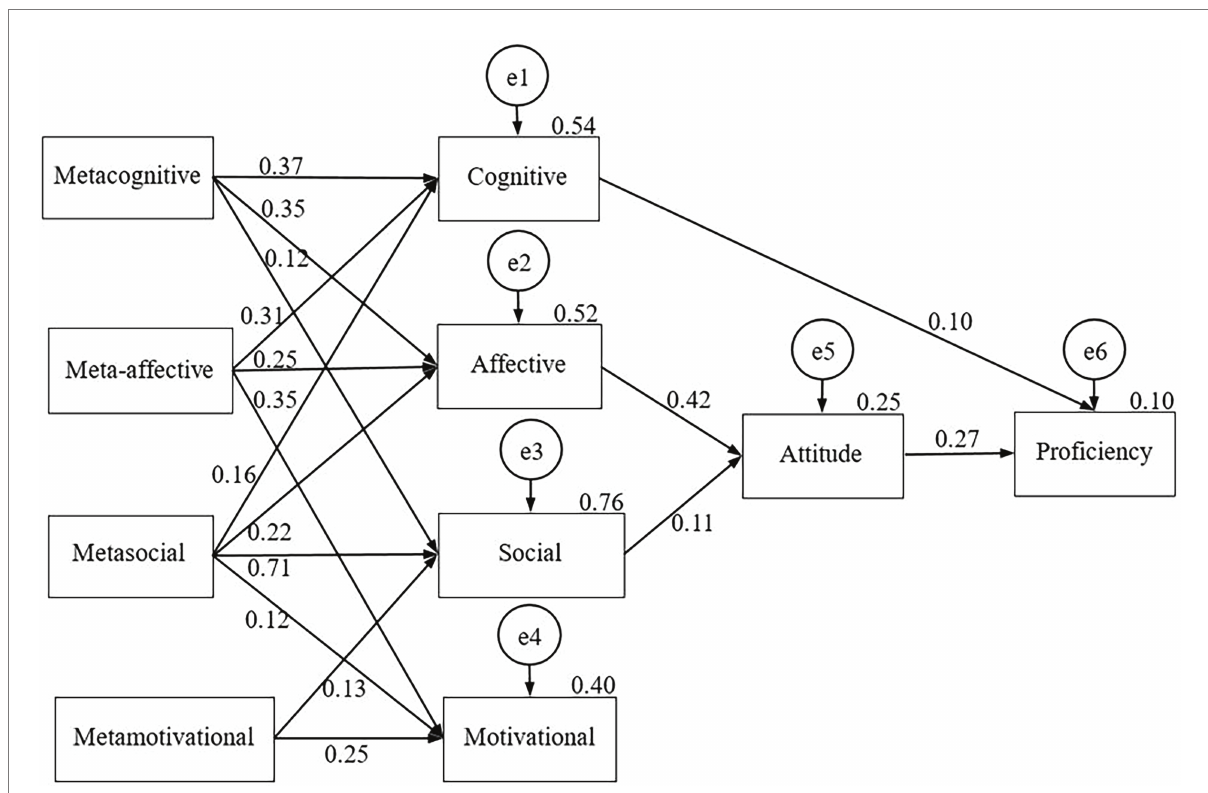
FIGURE 3 The path model for EFL metastrategies on regulation strategy use, attitude and English proficiency for low intermediate